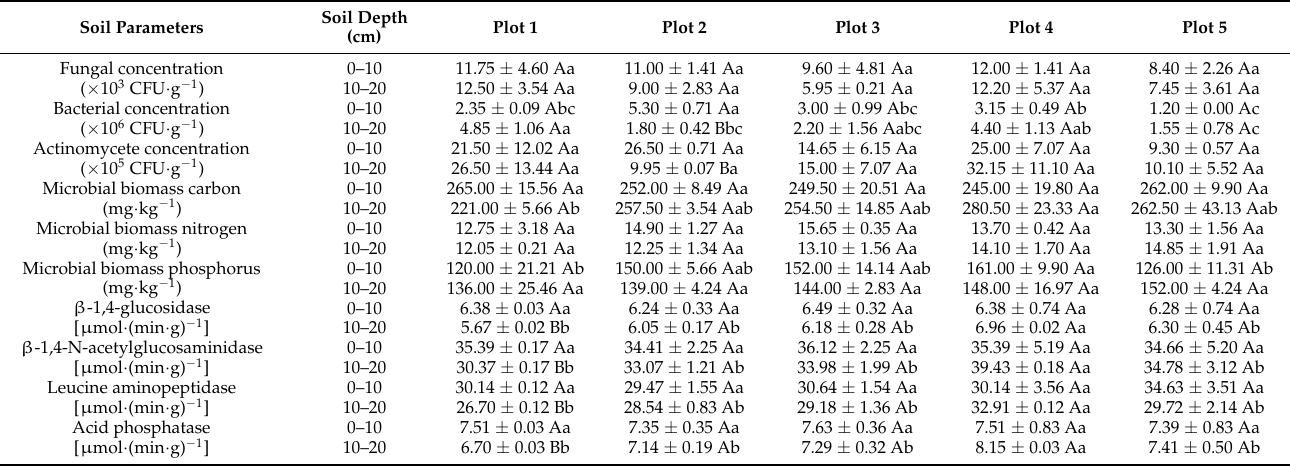
Table 3. Soil microbial concentration, biomass, and extracellular enzyme activity of Z. planispinum plantation in different planting